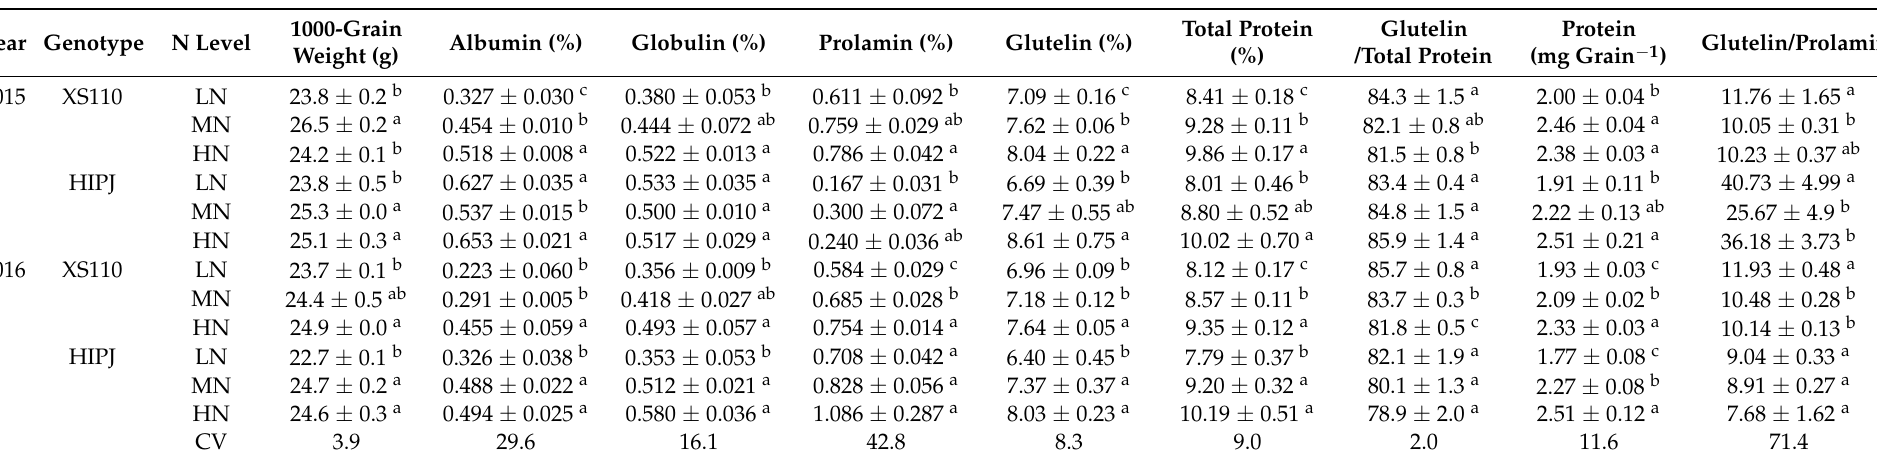
Table 2. Effect of N levels on grain dry weight, albumin, globulin, prolamin, glutelin, total protein concentration, glutelin/total protein, protein content in rice (Hydroponic